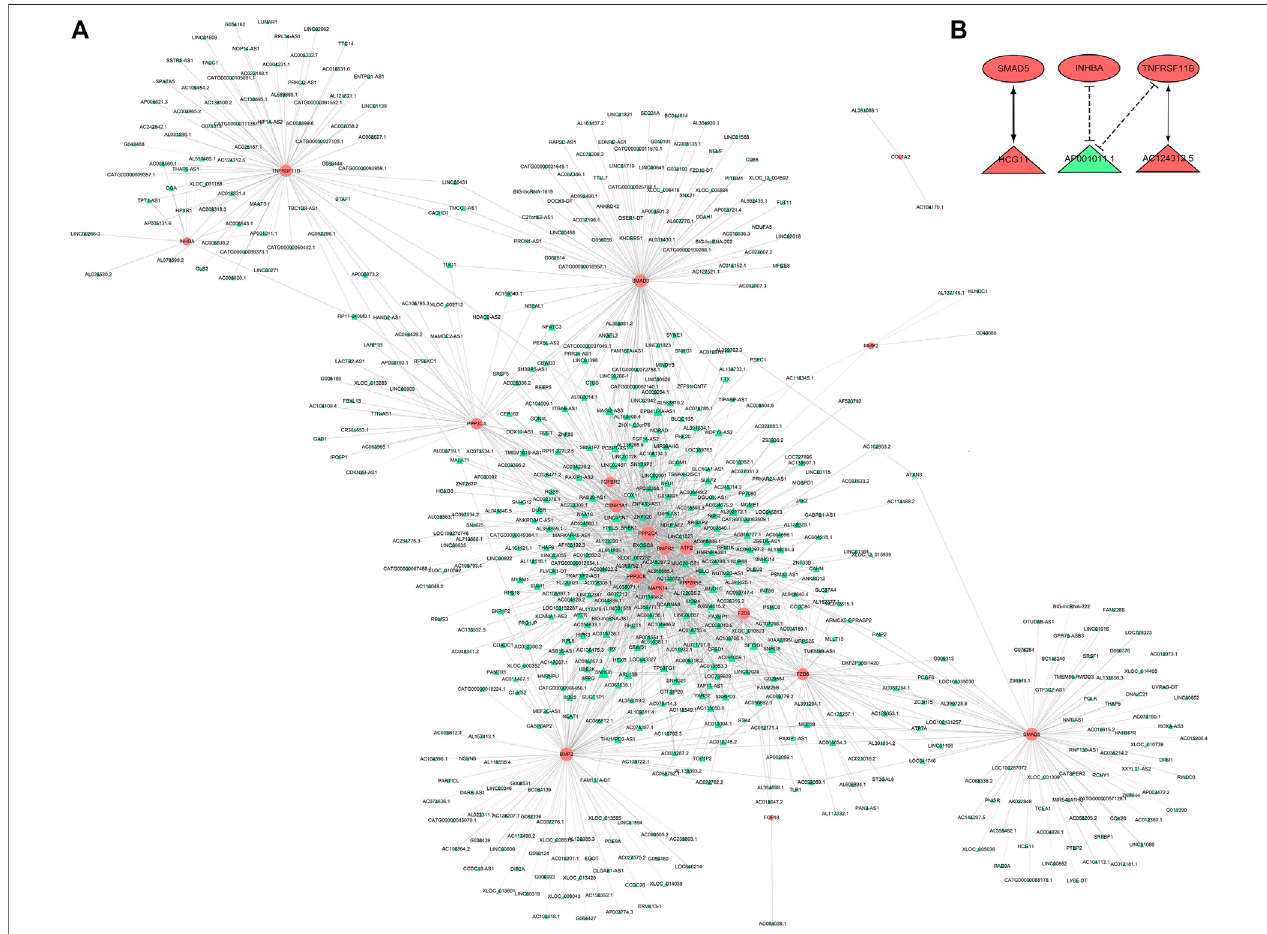
FIGURE 7 | CNC analysis. (A) CNC network between 19 DE mRNAs and all DE lncRNAs. Pink nodes were mRNAs; green nodes were lncRNAs. Positive correlation was solid line, negative correlation was dashed line. (B) CNC sub network. Red ellipses were mRNAs, red and green triangles were upregulated and downregulated lncRNAs, respectively. CNC, coding and noncoding co-expression; DE, differentially expressed.